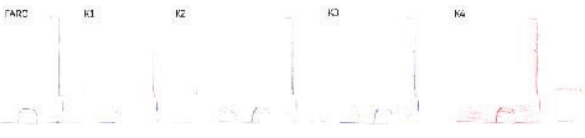
From the third to the fourth slot, in which the density of points is tripled compared to the previous ones, the representation becomes more reliable and legible even with details such as